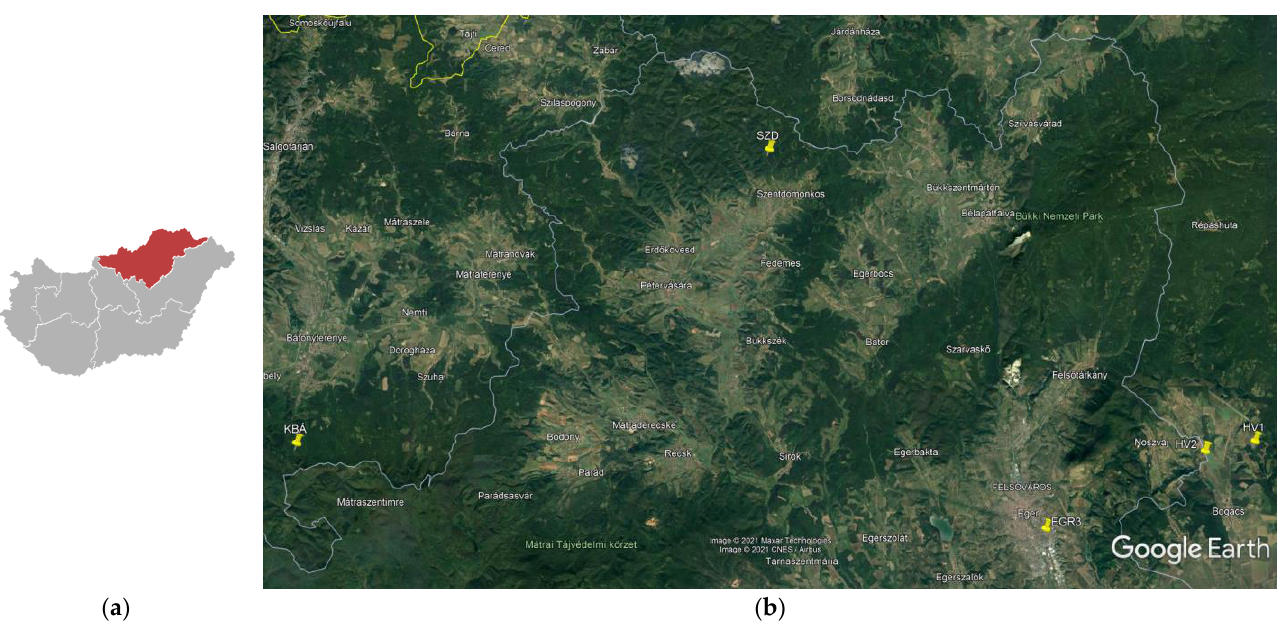
Figure 4. ( a ) A sketch map of Hungary with red highlighting of the Northern region. ( b ) Detailed map of the original locations of the investigated horsemint accessions (yellow line assigns the state border, grey lines are municipal borders). Mapping was performed with Google Earth Pro software package.